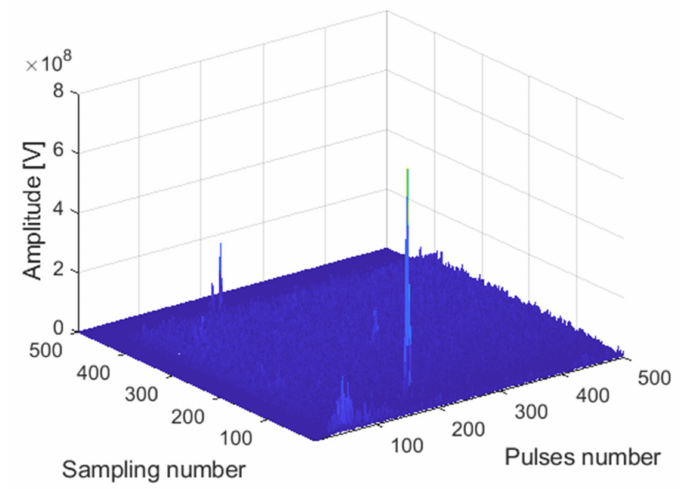
Figure 16. Matlab DBF result graph.